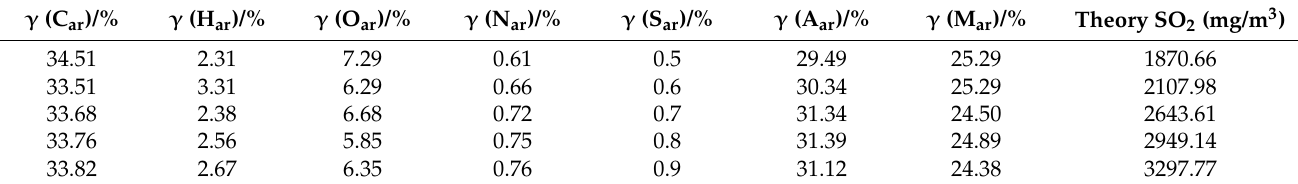
Table 1. Theoretical SO 2 concentration corresponding to different coal slime element content.